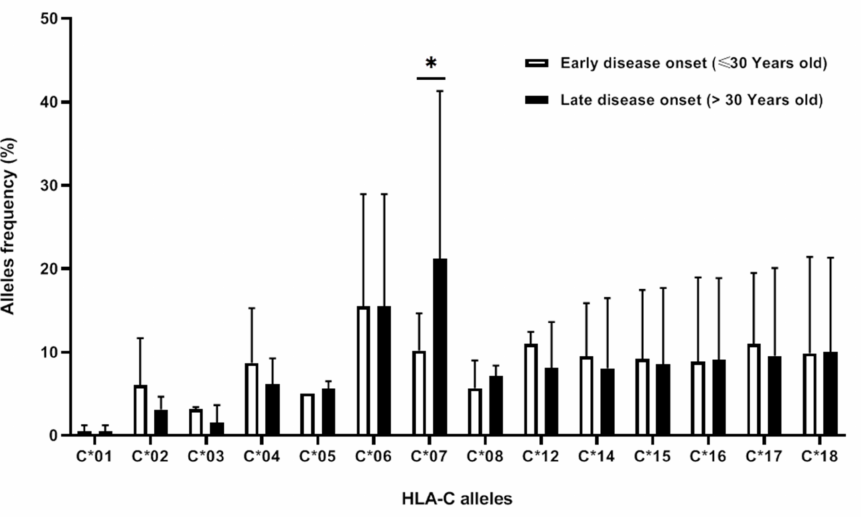
Figure 2. HLA-C allelic frequencies according to the age of disease onset. (*: p < 0.05 is statis- tically